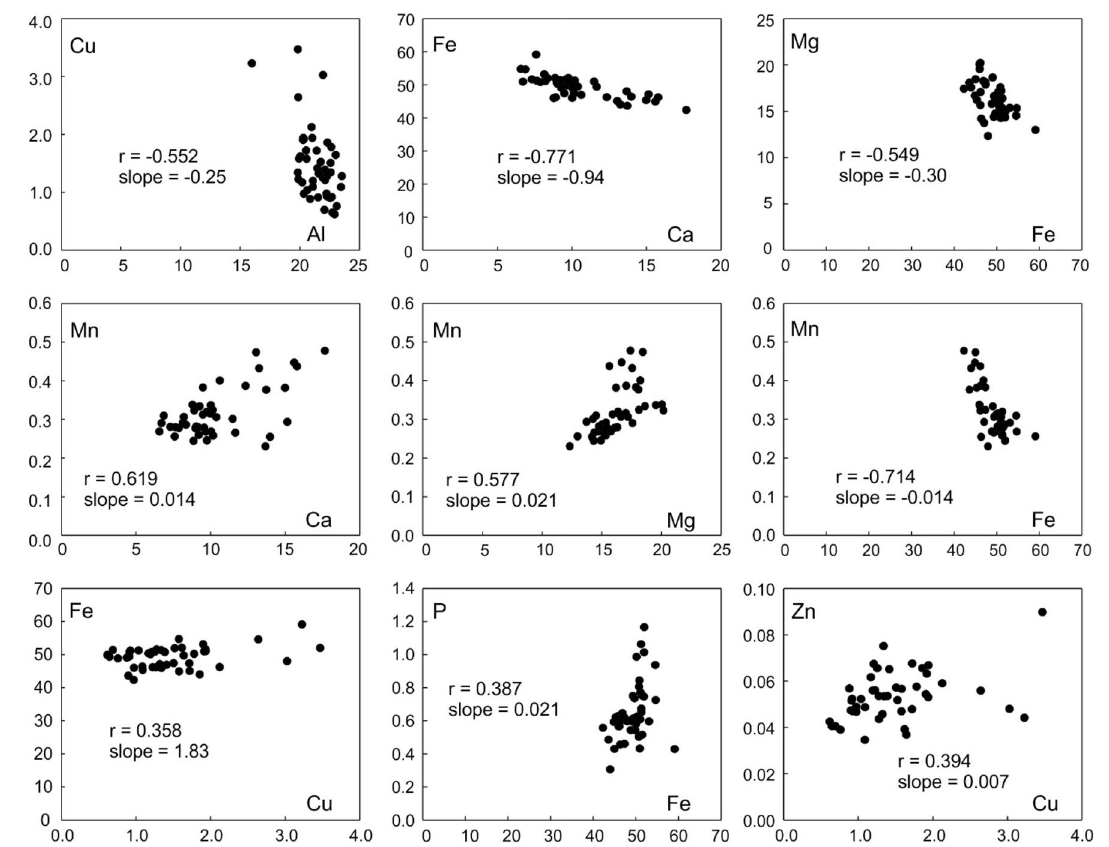
Fig. 2 Two-element plots showing correlations between element abundances as percentages (by mass) of the sum of concentrations of analysed elements as listed in Table